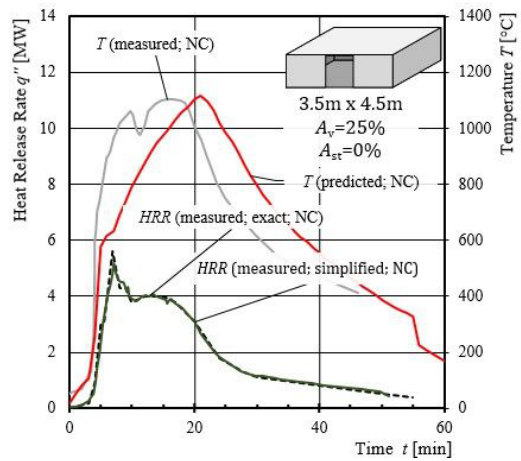
Figure 12: Predicted and measured temperatures for the HRR in baseline experiment I (NC).